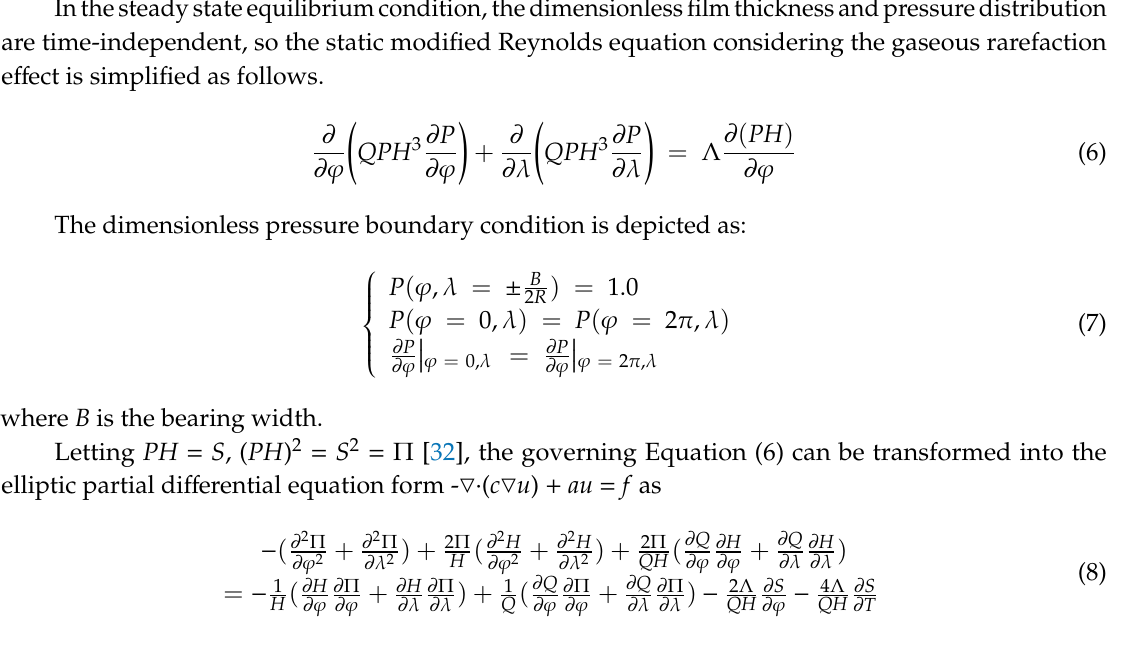
Figure 1. Schematic diagram and 3D views of gas-lubricated journal microbearings. ( a ) Schematic view; ( b ) 3D graphical representation.